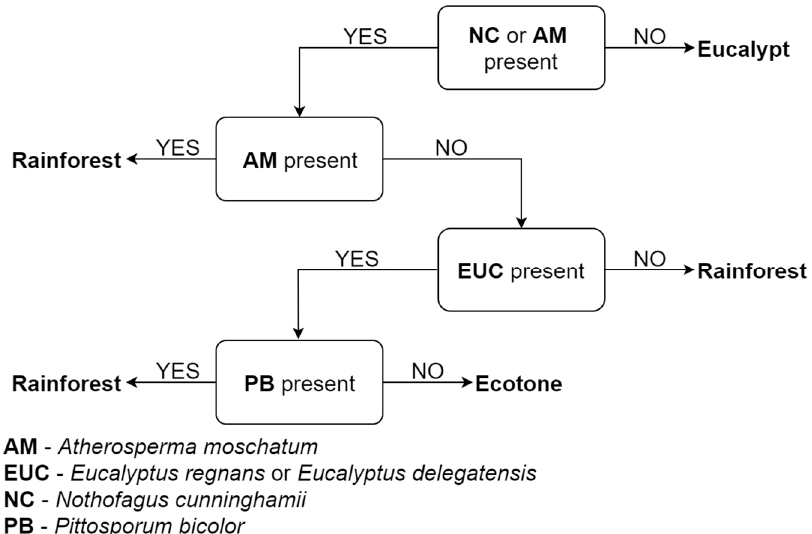
Figure 2. Landscape species model decision tree for classifying rainforest, ecotone, and eucalypt classes using the presence or absence of species which best separate stand types.